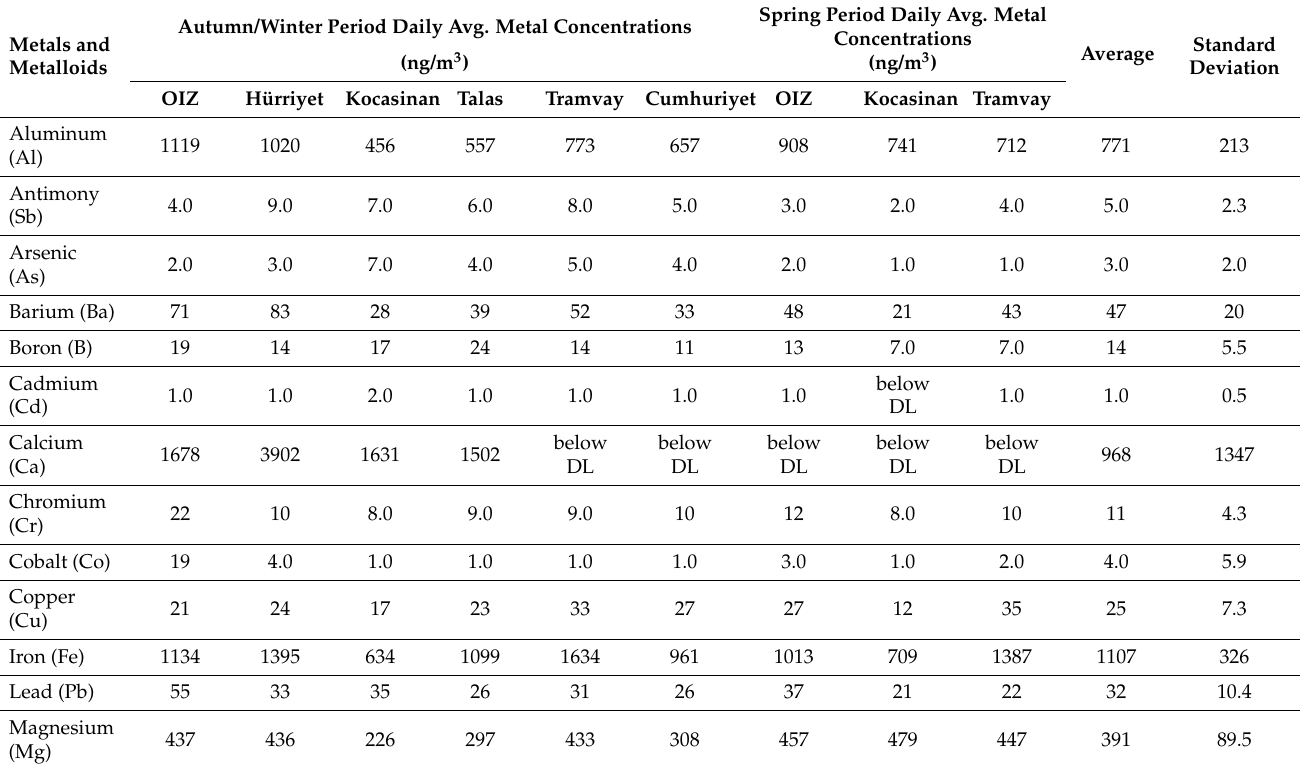
Table 3. Daily average metal and metalloid concentrations for autumn/winter and spring